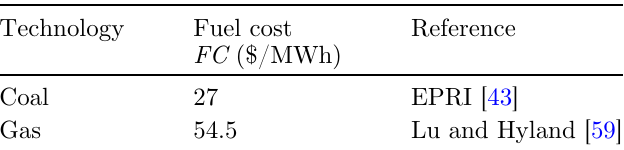
Table 10. Fuel costs for different fossil energy generation technologies.